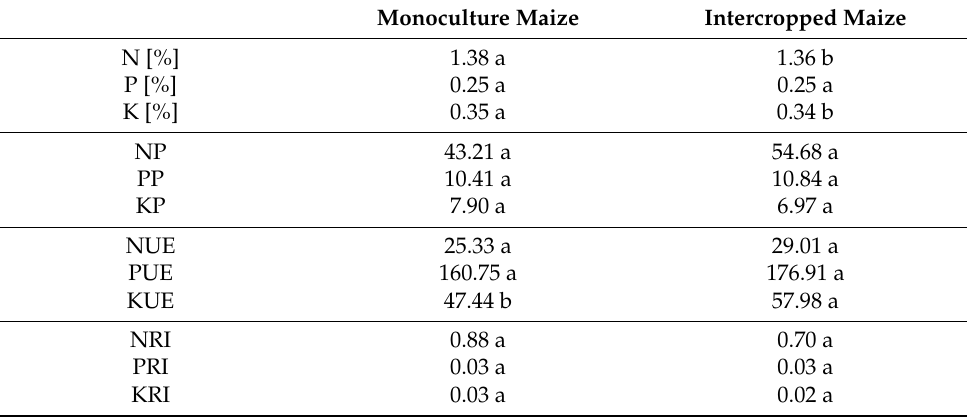
Table 6. Grain nutrient contents and nutrient indices; NP, PP, KP—grain productivity [kg ha −